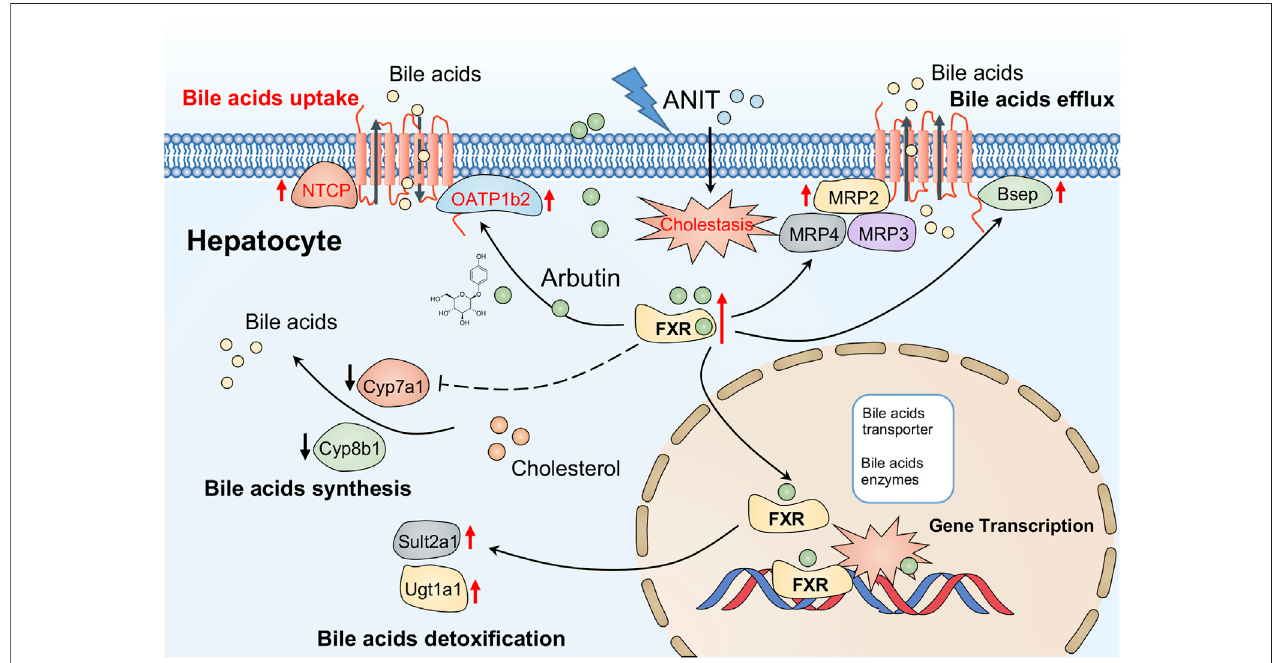
FIGURE 7 | Possible mechanism of arbutin alleviating hepatotoxicity associated with cholestasis induced by ANIT in this study.